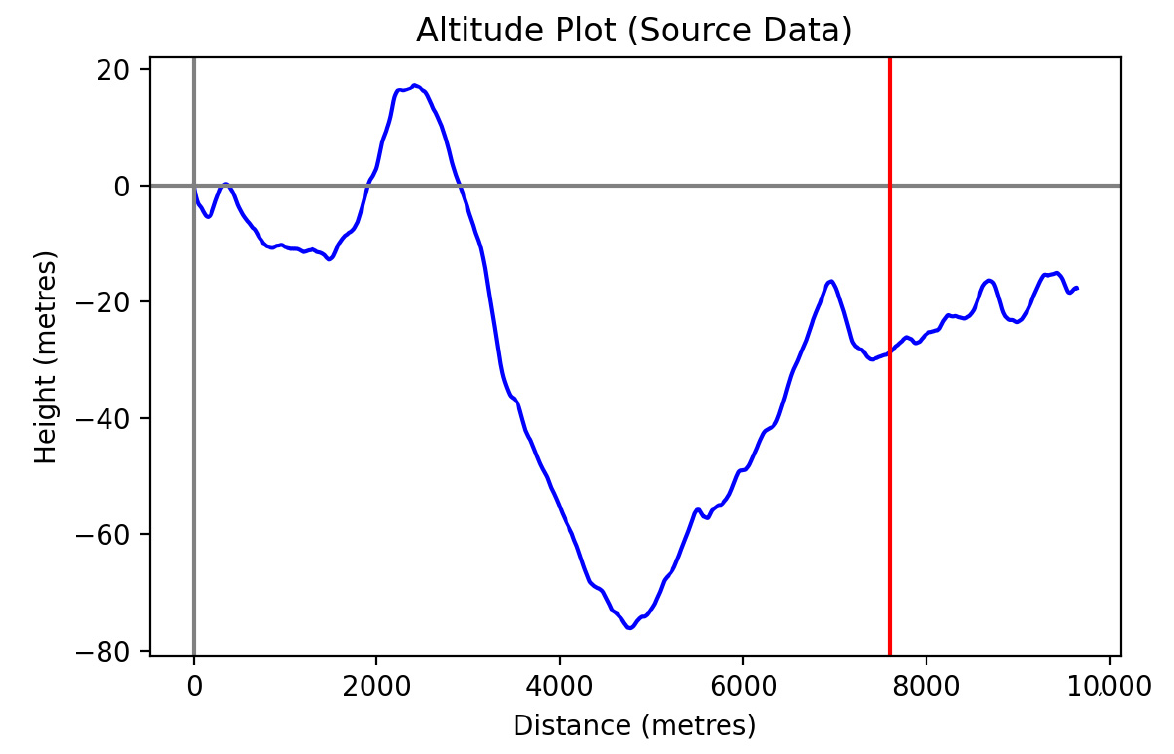
Figure 13. Studied road profile for Lisbon case study.